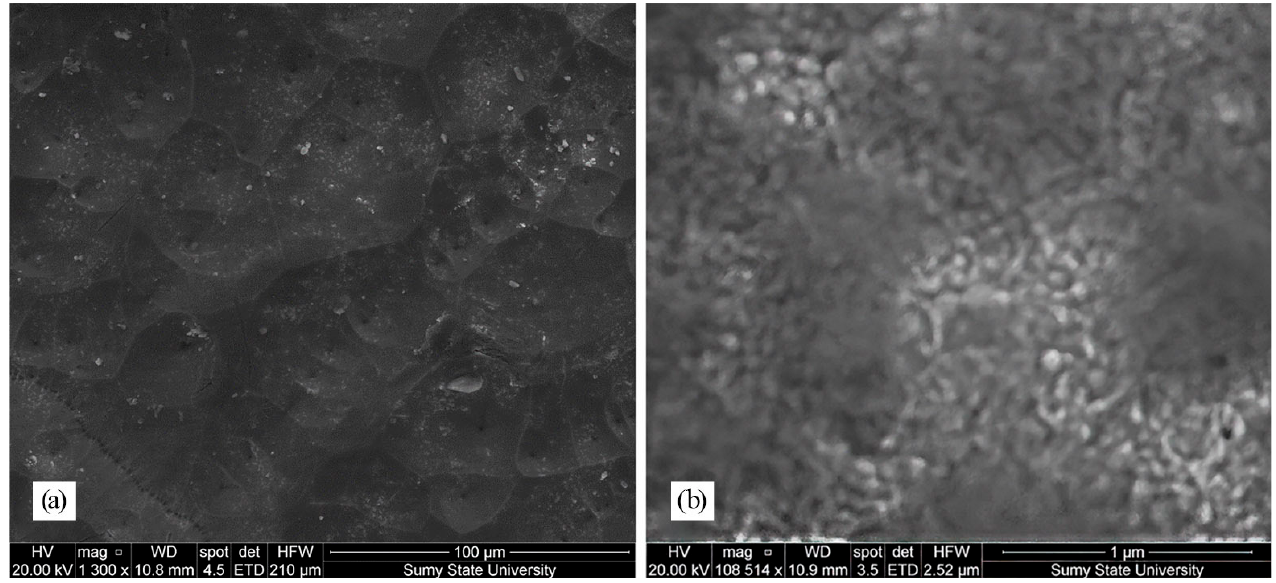
Figure 3. SEM images of the surface CdxTeyOz/CdS/ZnO heterostructure showing pinholes on the surface: ( a ) 1300× magni fi cation shows the surface interface, ( b ) magni fi cation of 108,514× shows the micromorphology of the surface.